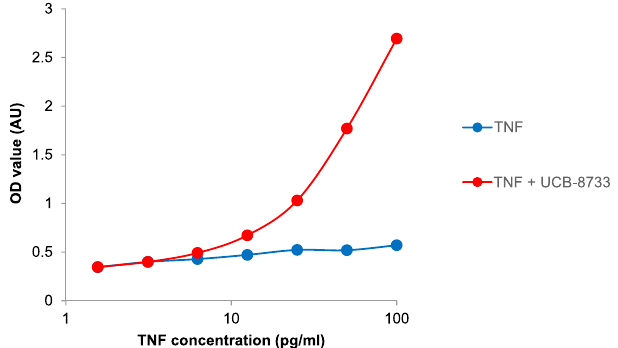
Fig. 6 CA1974 represents a suitable reagent for measuring target occupancy. CA1974 was used as a capture reagent to measure TNF complexed with UCB-8733 small-molecule inhibitor using a high-sensitivity ELISA, with a commercial anti-TNF antibody as the detection reagent. TNF pre-incubated with either excess compound or DMSO was spiked into neat human plasma (depleted of endogenous TNF) and diluted to various concentrations and used in the assay. TNF – small molecule complex signal (red) was signi fi cantly higher than apo – TNF background (blue), with probability of at least 0.999 at TNF concentrations of 25 pg/ml and above. Data from representative experiment. Source data from this and other experiments showing utility of CA1974 in measuring target occupancy are provided as a Source Data fi